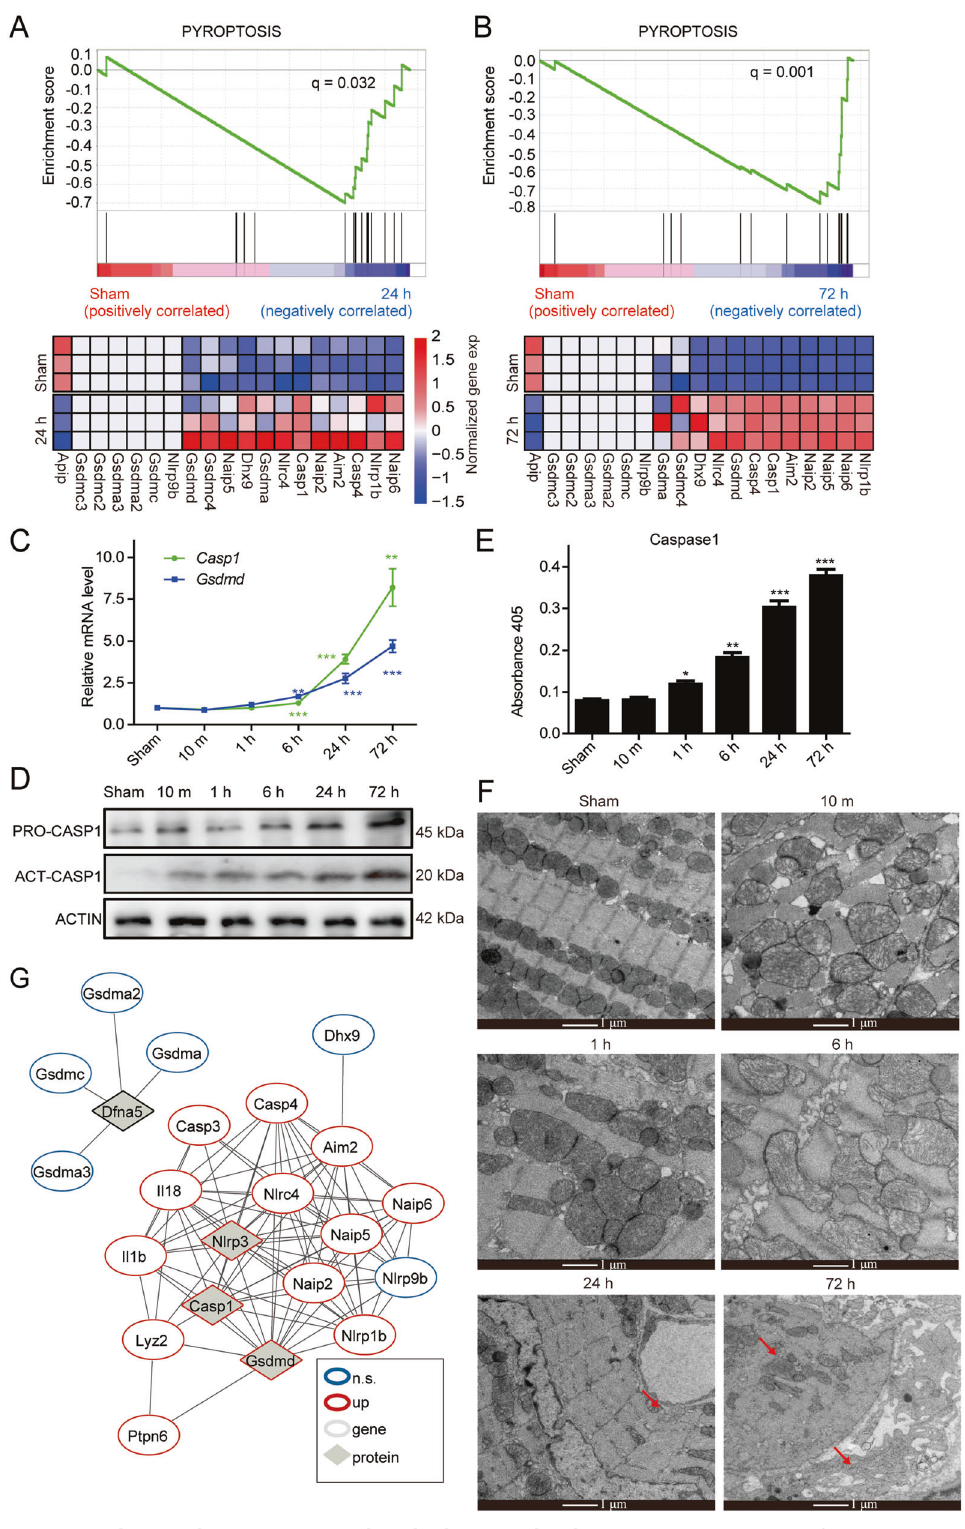
Fig. 3 The pyroptosis signaling pathway is activated with the AMI development. A , B GSEA results: pyroptosis-related genes are upregulated in the infarcted myocardia at 24 h ( A ) and 72 h ( B ) of AMI model. C qRT-PCR results show the continuously increased expression levels of the representative pyroptosis marker genes along the AMI development ( n = 3, ** P < 0.01, *** P < 0.001, Student ’ s t test). D Western blotting shows the continuously increased protein levels of PRO-CASP1 and ACT-CASP1 along the AMI development. E The continuously increased activity of the pyroptosis marker gene Caspase1 during the AMI development ( n = 3, * P < 0.05, ** P < 0.01, *** P < 0.001, Student ’ s t test). F Electronic microscopic results show the morphologic changes in the AMI samples compared to the sham samples. Arrows indicate pyroptotic bodies (Bar = 1 μ m). G The network composed of the pyroptosis signaling pathway genes indicates the active interactions. n.s. not signi fi cant. Cell Death and Disease (2021)